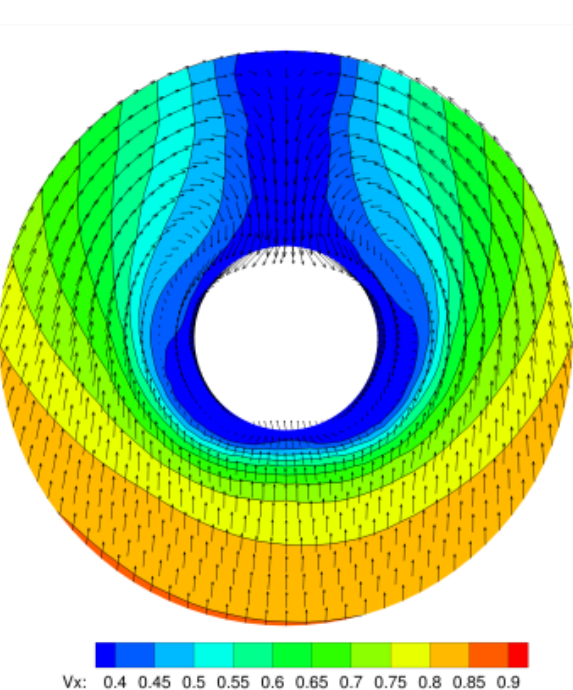
Figure 7: Nominal and Effective wakes in full scale